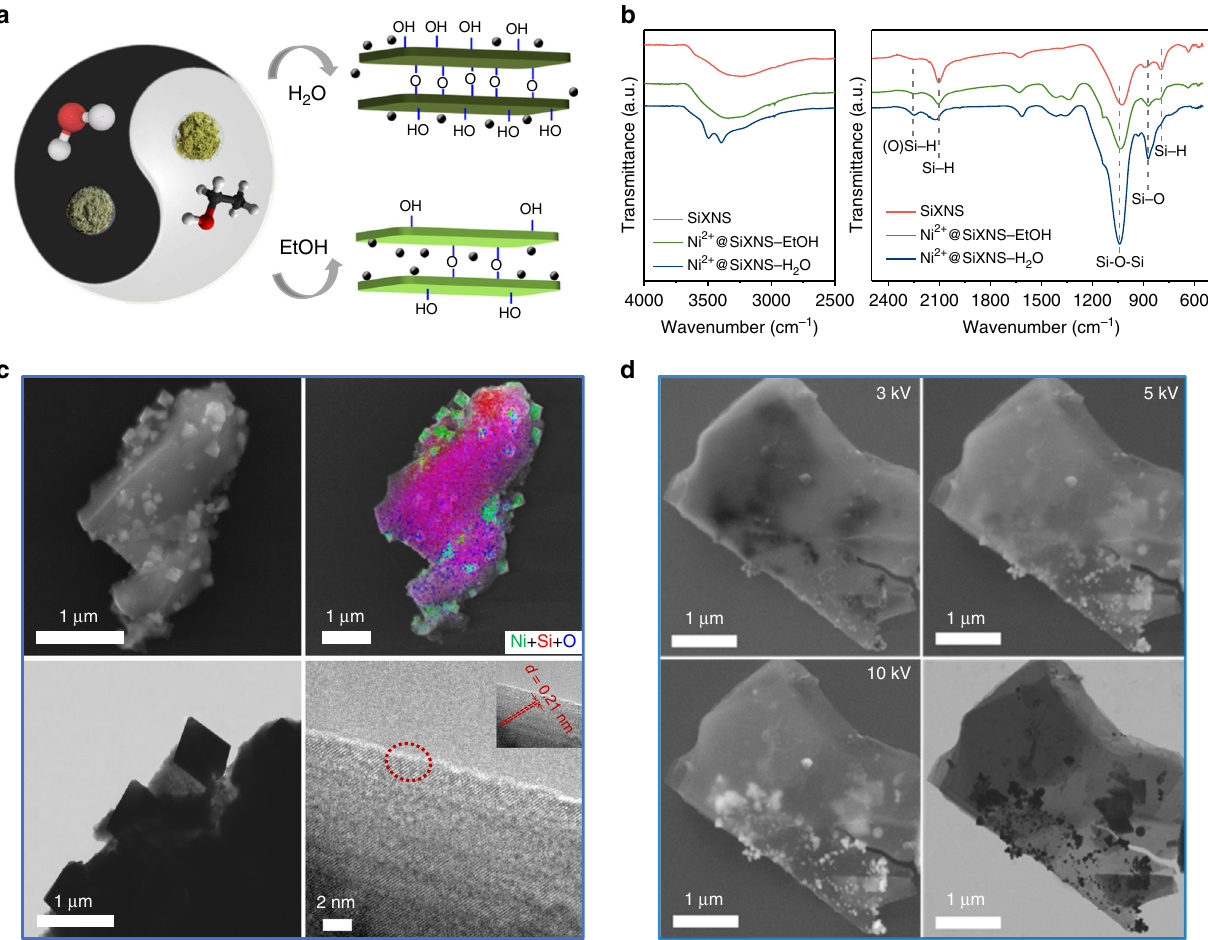
Fig. 1 Preparation, growth, and electron microscopy characterization of NiO@SiXNS. a Structures of two different Ni 2 + -impregnated SiXNS samples. The taijitu symbolizes the fact that, when used as the solvent, H 2 O and EtOH, result in two distinct composite structures, despite being derived from the same solid siloxene precursor. The black spheres around the green SiXNS slabs indicate the Ni 2 + ions. b FTIR spectra of pristine SiXNS and SiXNS impregnated with Ni 2 + ions in EtOH and H 2 O. c Scanning electron microscopy (SEM) with energy-dispersive X-ray (EDX) and transmission electron microscopy (TEM) images of NiO@SiXNS-H 2 O, and d SEM and TEM images of